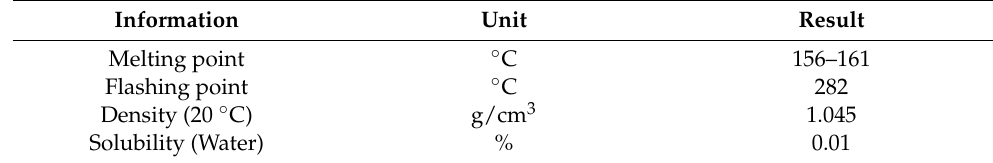
Figure 1. The decomposition chemical equation of antioxidant 1098. Table 4. Basic physical properties of antioxidant 1098.